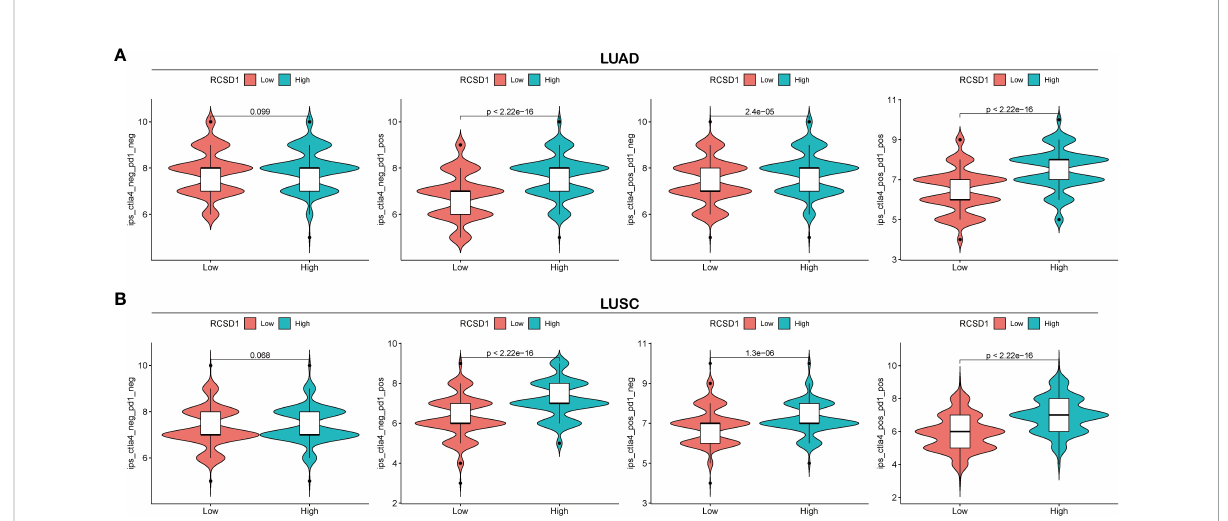
FIGURE 12 Relationship between RCSD1 expression and immunotherapy. (A) IPS score for the high and low RCSD1 expression group in LUAD. (B) IPS score for the high and low RCSD1 expression group in